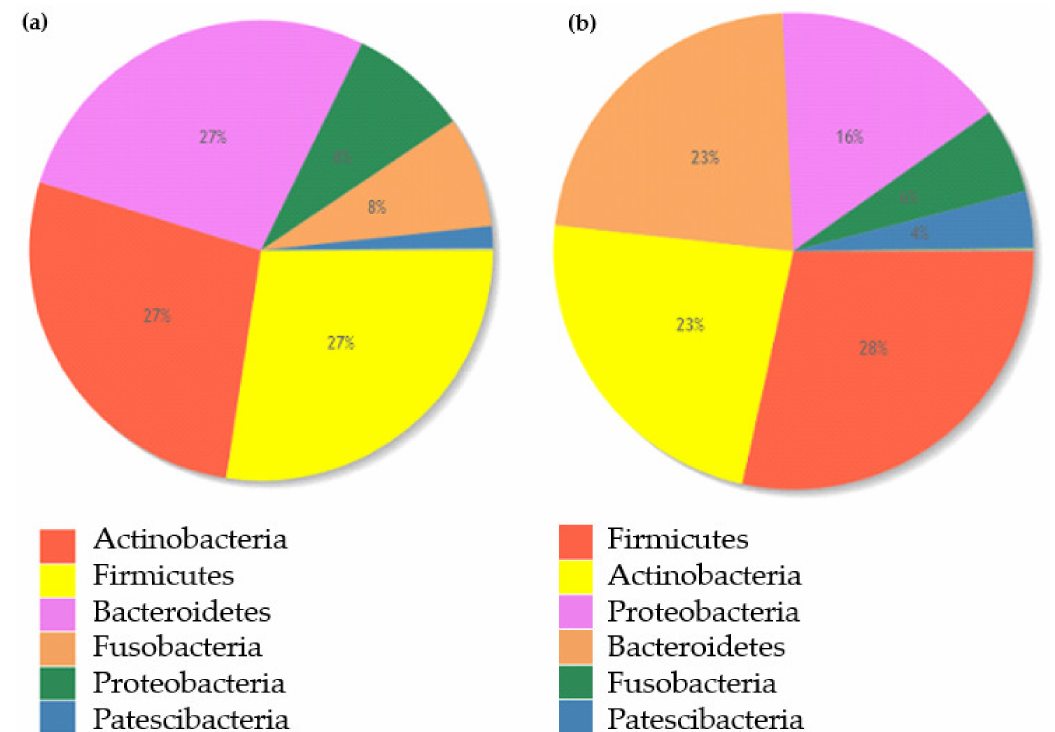
Figure 4. ( a ) Percentage distribution of the oral cavity microbiota of the patients with PD at the phylum level. ( b ) Percentage distribution of the microbiota of the oral cavity of the healthy controls at the phylum level.